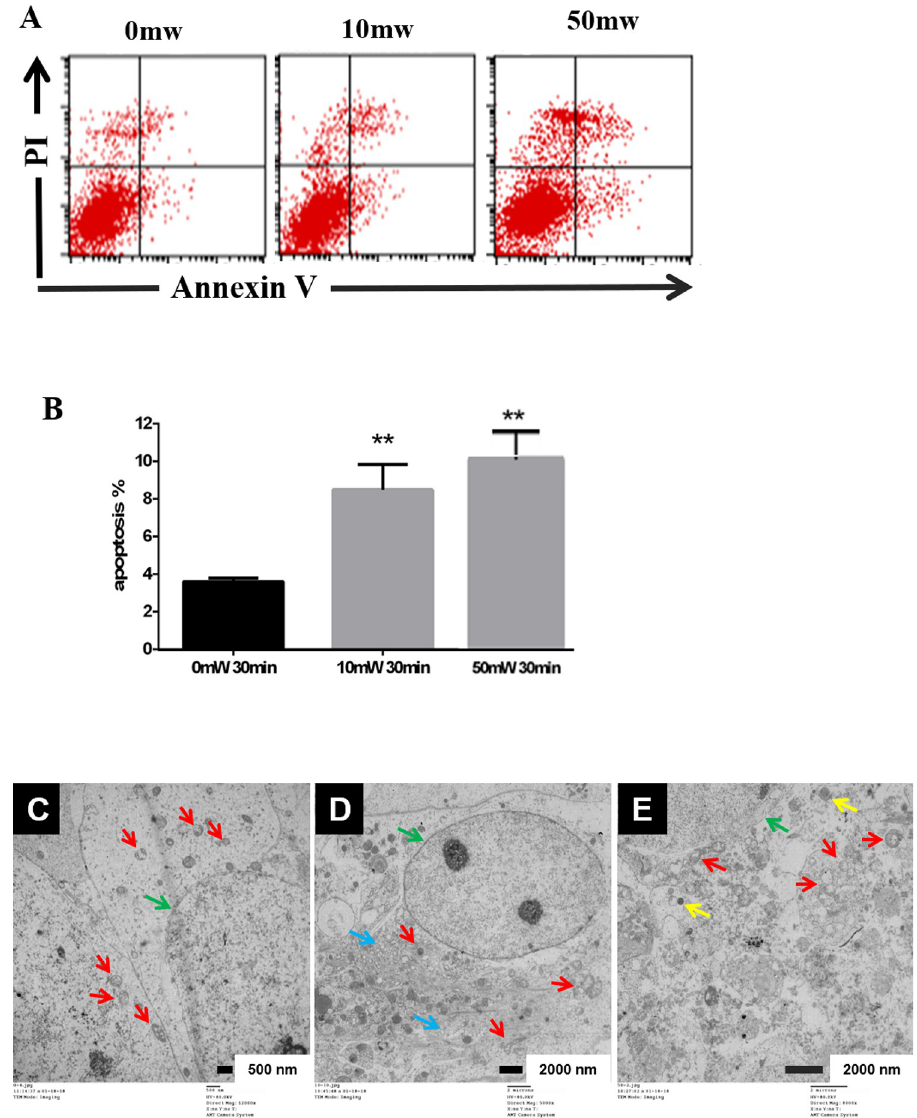
Fig 2. Effect of terahertz radiation on the apoptosis and ultrastruture of primary hippocampal neuron. Rat hippocampal neurons were radiated by 0.12 THz with power of 10 mW for 30 min or by 0.157 THz with power of 50 mW for 30 min. Apoptosis was analyzed by flow cytometry using Annexin V and propidium iodide staining immediately after terahertz radiation. The representative images were shown in A , and the statistical analysis were shown in B. Sham-irradiated cells were used as the controls. Three independent experiments were conducted. Data were shown as mean ± s.e.m. �� p < 0.01 vs sham group. The ultrastructure of the cell was examined by transmission electron microscopy (TEM) after exposure to sham-radiation ( C ), 0.12 THz radiation with power of 10 mW for 30 min ( D ), or 0.157 THz radiation with power of 50 mW for 30 min ( E ). Organelles are indicated by arrows, green: nucleus; red: mitochondria; blue: ER; yellow: lysosome. Scale bars are 500 nm in C, and 2 μ m in D and E .